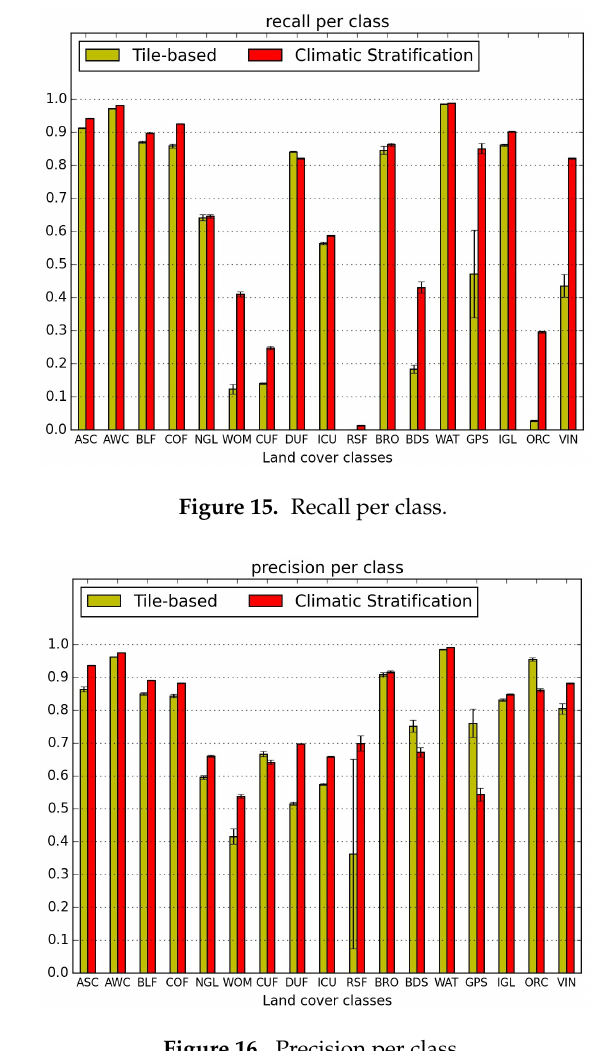
Figure 16. Precision per